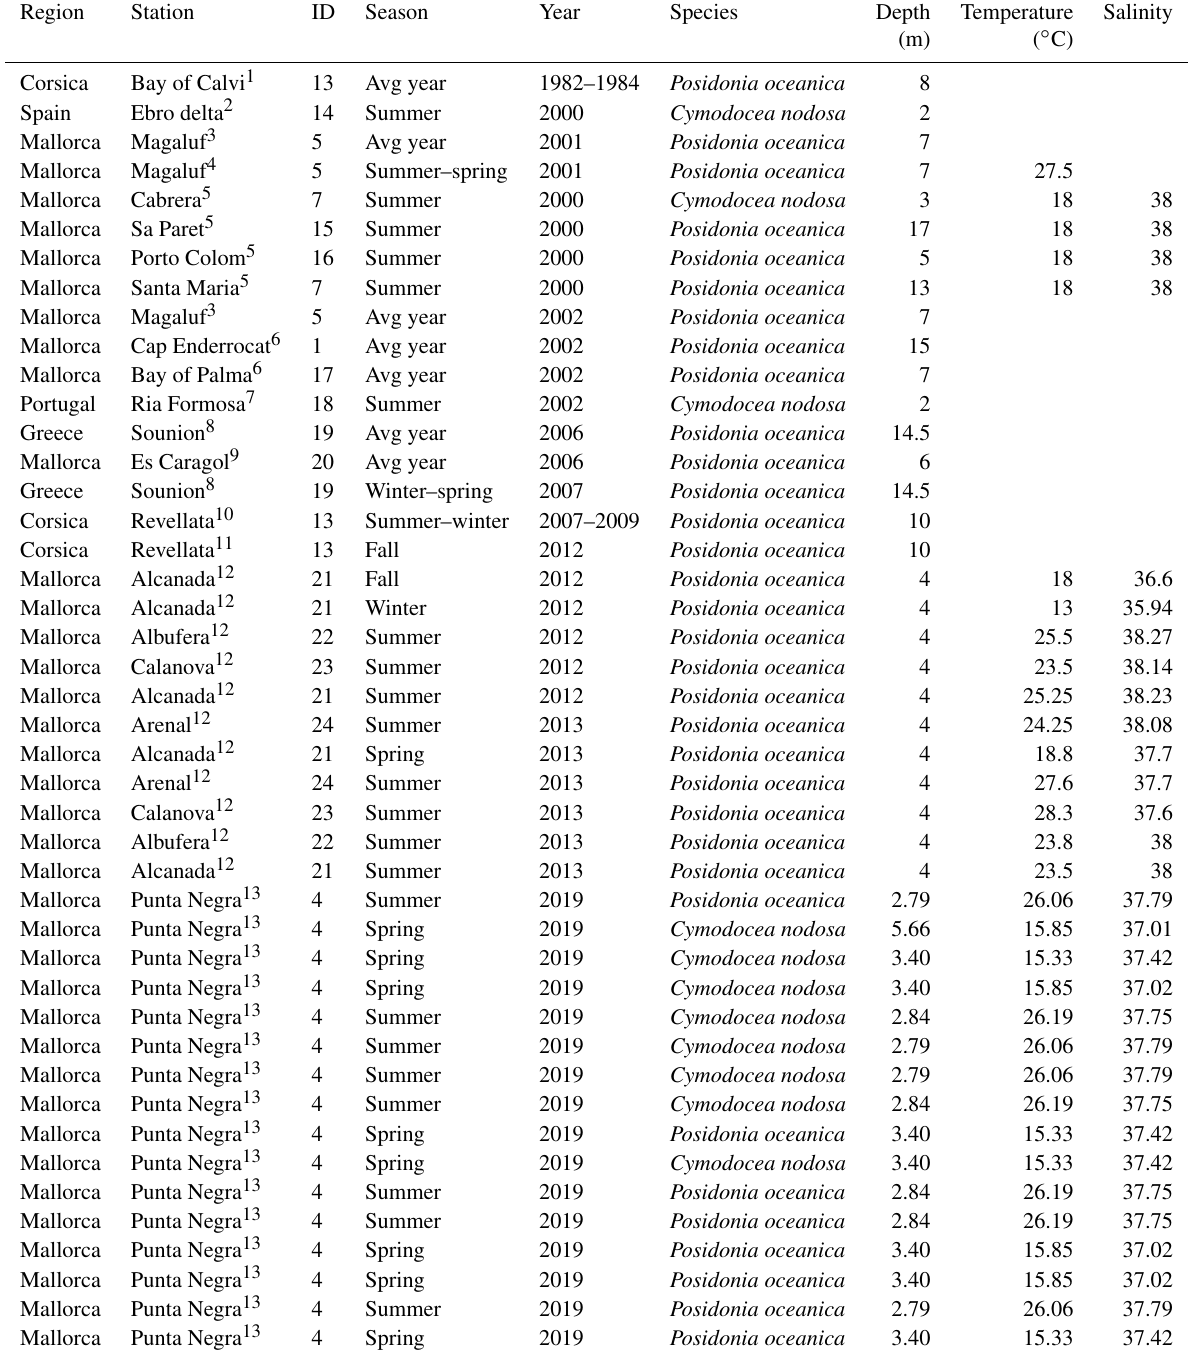
Table 2. Characteristics of sampling stations with data for benthic-chamber deployments. Temperature and salinity represent average values during the